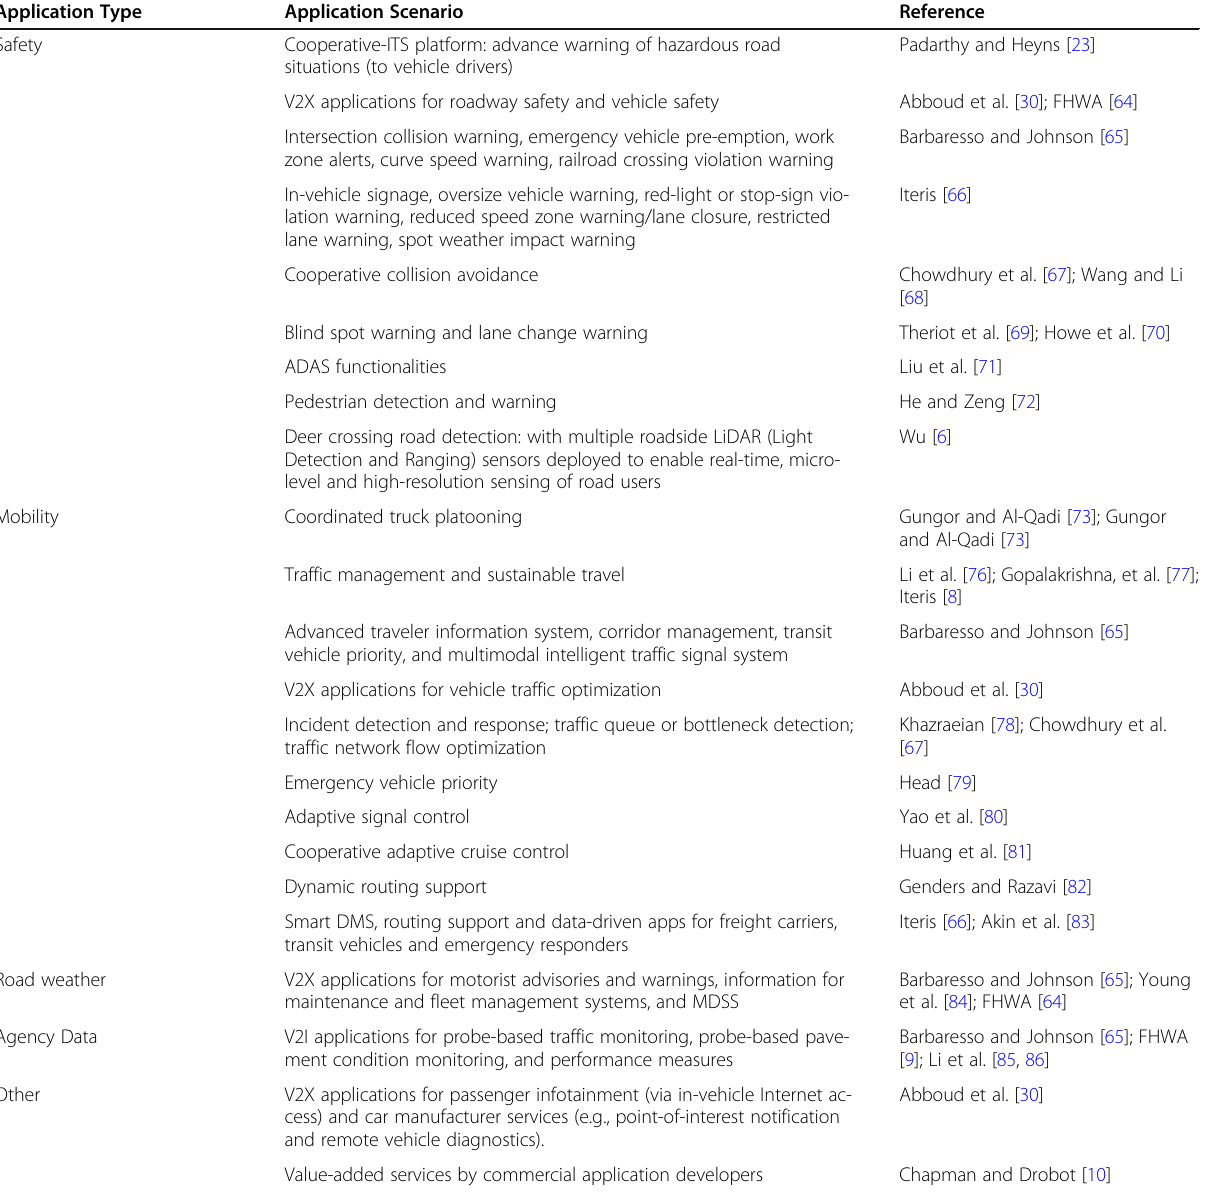
Table 2 Some identified application scenarios of VII system Application